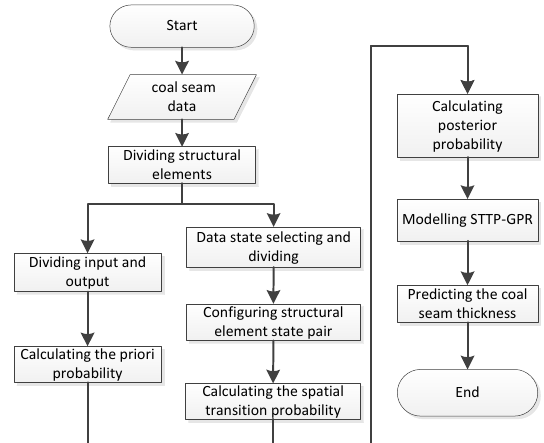
Figure 7. Flowchart of structural element transition probability based Gaussian process progression (STTP-GPR).